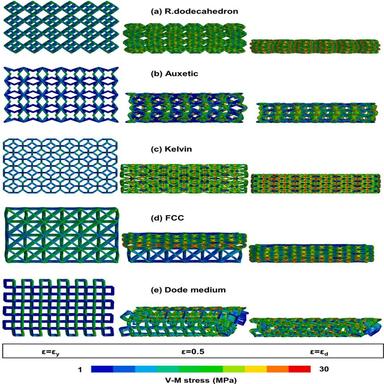
Bending of the struts with effective stress at different strains (yield, 50%, and end of the plateau) for set 1 structures: a) rhombic dodecahedron, b) auxetic, c) kelvin, d) FCC, and e) dode medium.